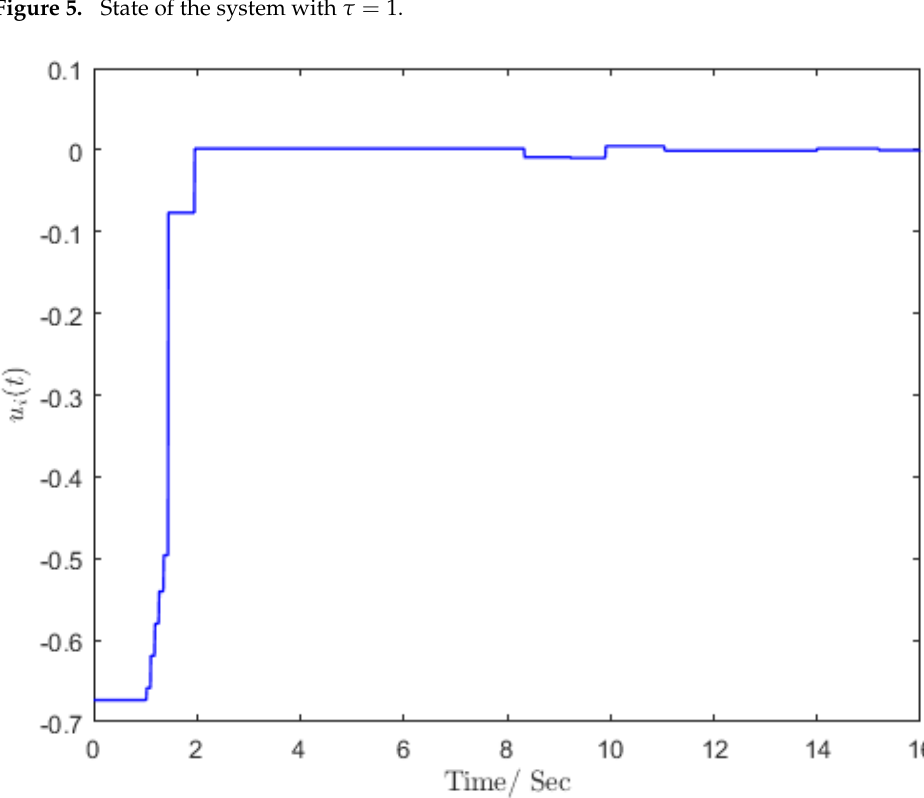
Figure 6. Controller with event–triggered impulse and τ = 1